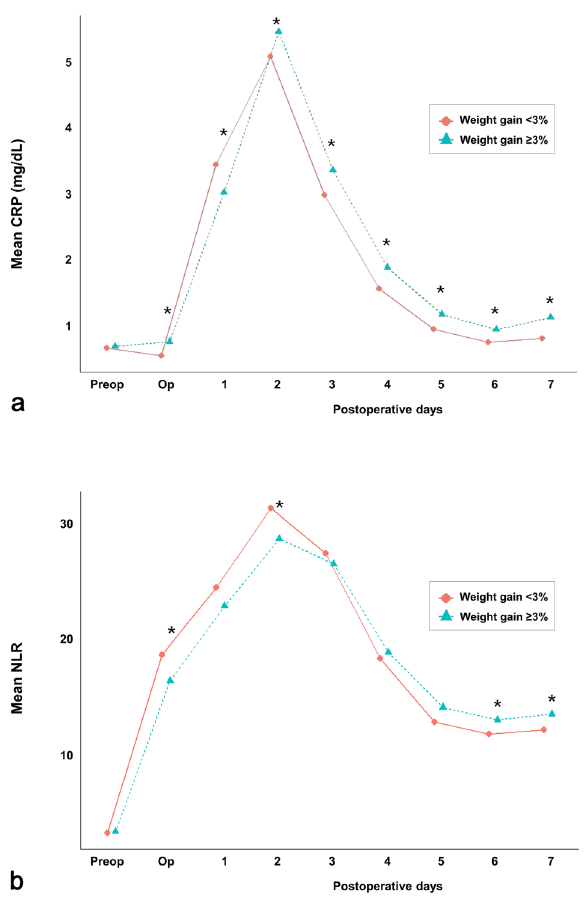
Figure 4. Sequential changes in mean ( a ) CRP and ( b ) NLR values in living donor liver transplantation recipients, * P < 0.05. Abbreviations: CRP, C-reactive protein; NLR, neutrophil-to-lymphocyte ratio;